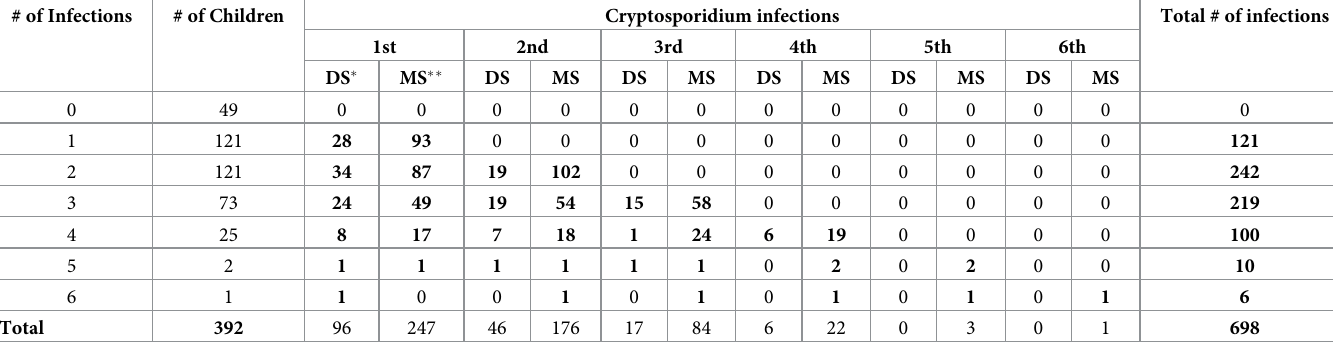
total number of Cryptosporidium infections during the follow-up (Fig 4A). However, the total number of Cryptosporidium infections was negatively associated with HAZ score at 3 years (Fig 4B, regression coef=-0.152, p=0.0004) The association between HAZ and Cryptosporidium spp . infections was unaffected by whether the event was a sub-clinical infection or diarrheal disease (S5 Fig). Other measurements that are used as indicators of malnutrition were also significantly asso- ciated with the number of Cryptosporidium infections. These included mid-upper arm circum- ference (MUAC) (S6A Fig; MUACZ vs. number of Cryptosporidium infections slope: -0.088; p=0.0123 and weight-for-age (WAZ score) (S6B Fig) (linear regression analysis slope: -0.115 p=0.0093). However, neither BAZ (body-mass- for- age) (S6C Fig), used to measure acute pro- tein-energy malnutrition or wasting (WHZ) were affected by a history of Cryptosporidium infections (S6D Fig). The Pearson correlations among the number of Cryptosporidium infections, LAZ at birth, diarrheal episodes and HAZ at year 3 confirmed the results of the linear regression analysis ( Cryptosporidium infections: HAZ at year 3: coef = -0.18, p=0.024; Cryptosporidium infections: diarrheal episodes captured (all causes): coef = 0.22, p < 0.0001; HAZ at year 3: LAZ at birth: coef = 0.28, p= 0.008). As expected, a significant correlation existed between LAZ at birth and HAZ at year 3 (simple linear regression p < 0.0001 Fig 5A). Enteric pathogens are endemic in the Bangladesh study population [28] and as a conse- quence, infants enrolled in the study cohort had repeated diarrheal episodes of which only some were associated with infection with the Cryptosporidium parasite. However, while Cryp- tosporidium infections (diarrheal and sub-clinical) were significantly associated with child HAZ at year 3 (Pearson’s correlation p=0.0004), the number of all-cause diarrheal episodes was not (Fig 5B and Tables 3 and S1). This result supported our conclusion that this growth shortfall was specifically associated with recurrent cryptosporidiosis. Table 2. Distribution and Clinical Characterization of repeated Cryptosporidium